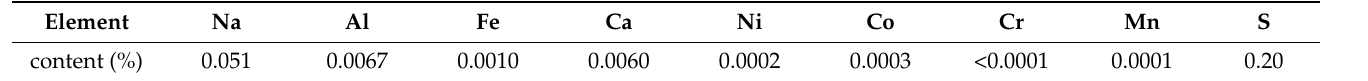
Table 4. Elemental analysis of MgO after aging by NaOH.